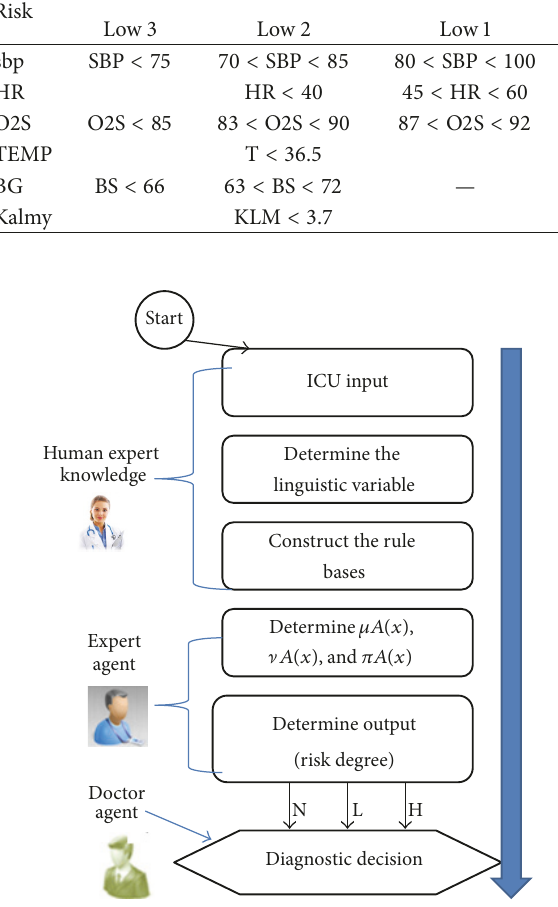
Figure 2: The flowchart for MIFEDSS diagnosis process